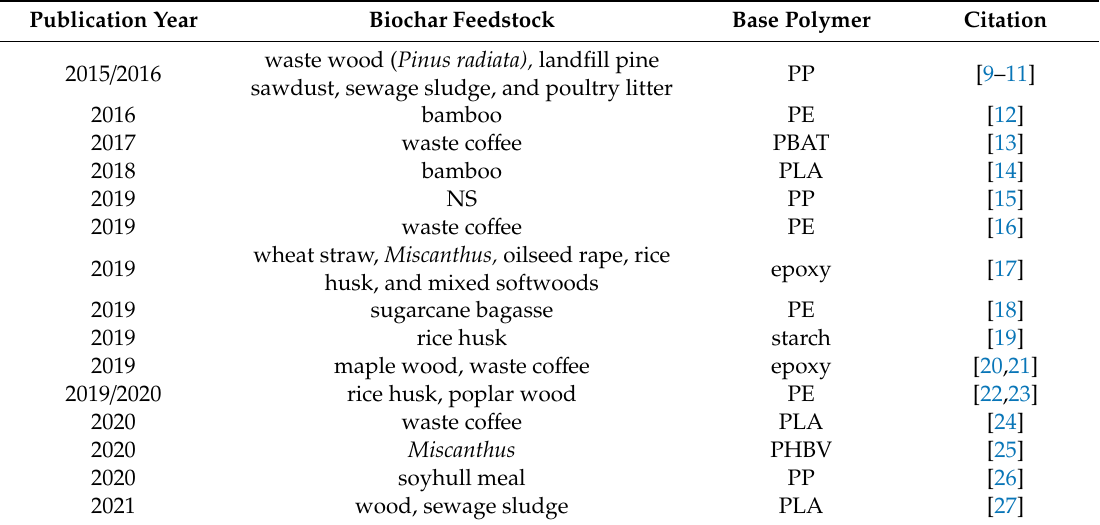
Table 1. Selected studies since 2015 reporting biochar–plastic